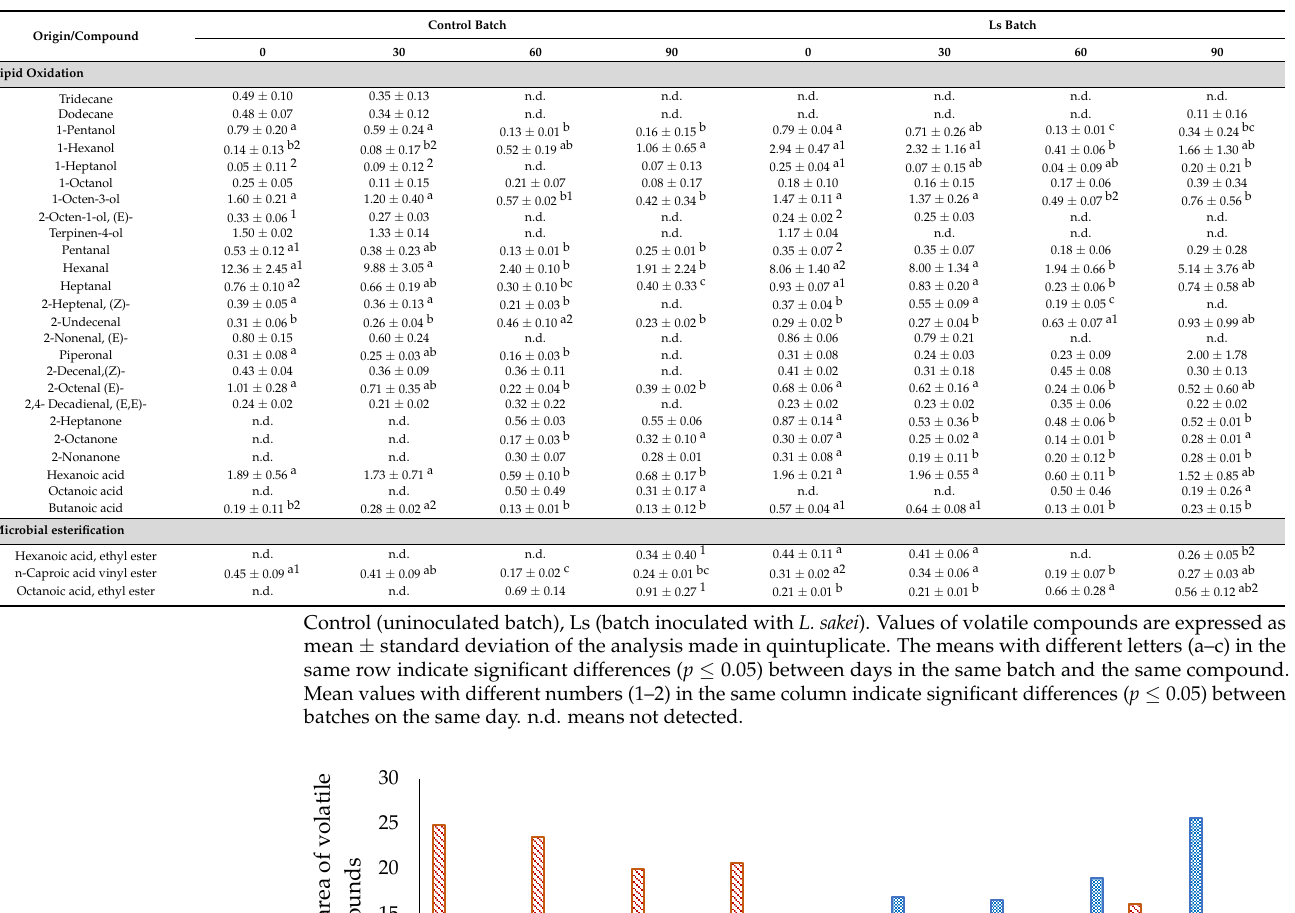
Table 1. Profiles of volatile compounds (lipid oxidation and microbial esterification) of Control (uninoculated batch) and Ls (batch inoculated with Lactilactobacillus sakei ) batches during the ripening process (0, 30, 60, and 90 days) of dry-cured fermented sausages (Arbitrary Area Units × 10 6 ). ControlBatch LsBatch Origin/Compound 30